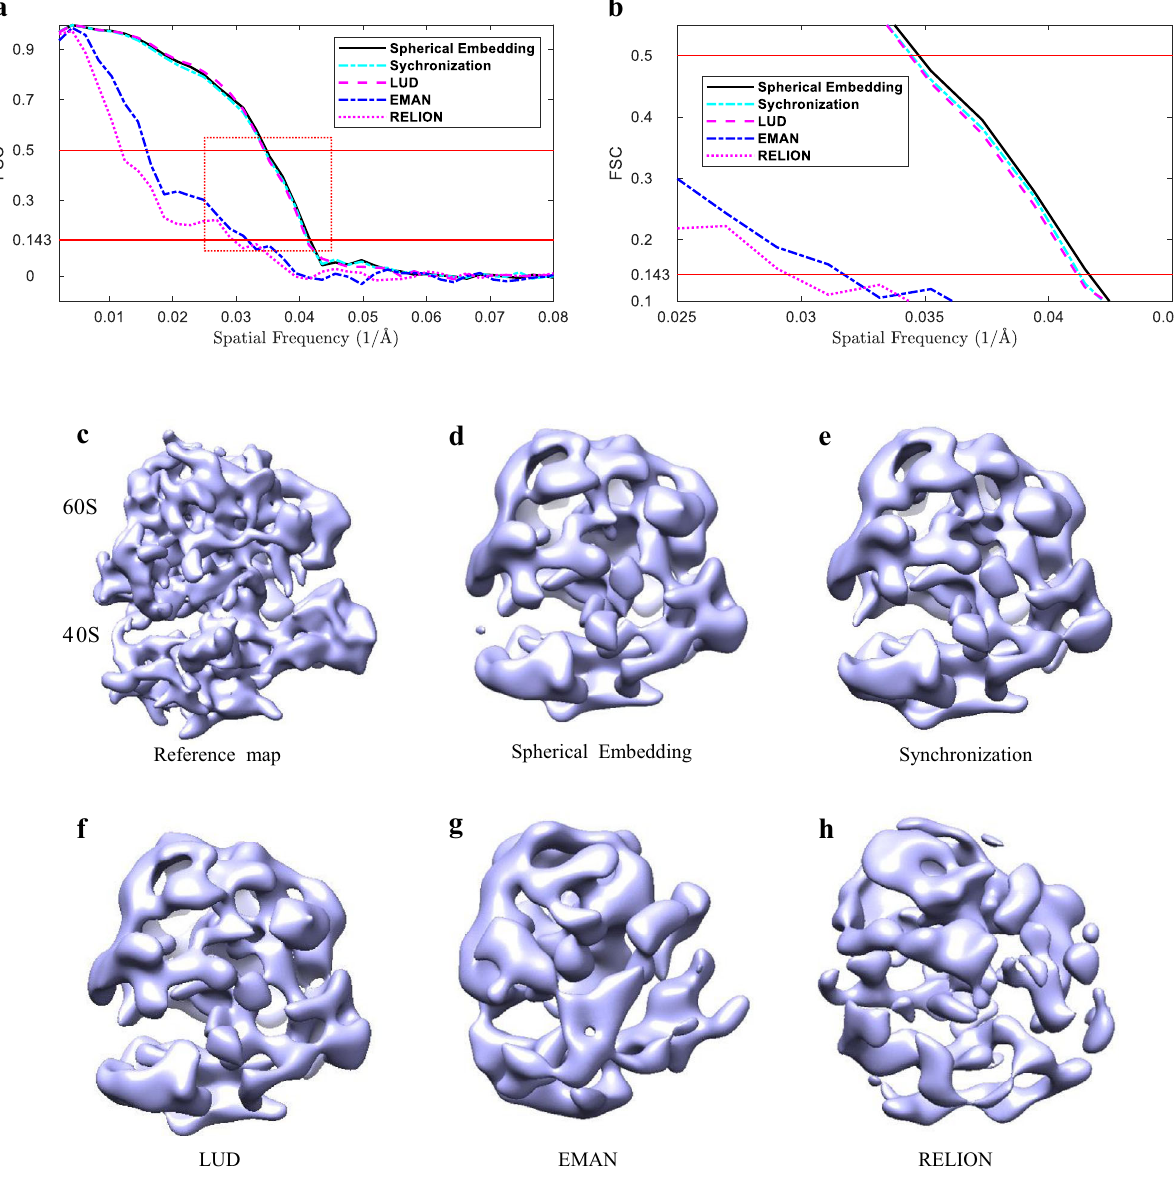
Fig. 5 Evaluation using the FSC curves and the reconstructions for the EMPIAR-10028 dataset. a Comparison of the FSC curves produced by the proposed method (Spherical Embedding), Synchronization, LUD, EMAN 2.1, and RELION-2. b The zoom-in of the red dashed rectangle region in ( a ), which shows the details of the FSC curves around the spatial frequency of 0.04 1/Å. c The reference density map (EMD-2660). Others are the reconstructed maps from the class averages by: d the proposed method (Spherical Embedding), e Synchronization, f LUD, g EMAN 2.1, and h